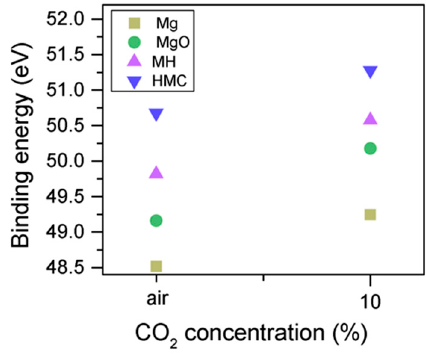
Figure 7. Mg2p BE for samples exposed to air and CO 2 for seven days. Table 5. Mg2p and O1s peak information for samples exposed to air and 10% CO 2 .